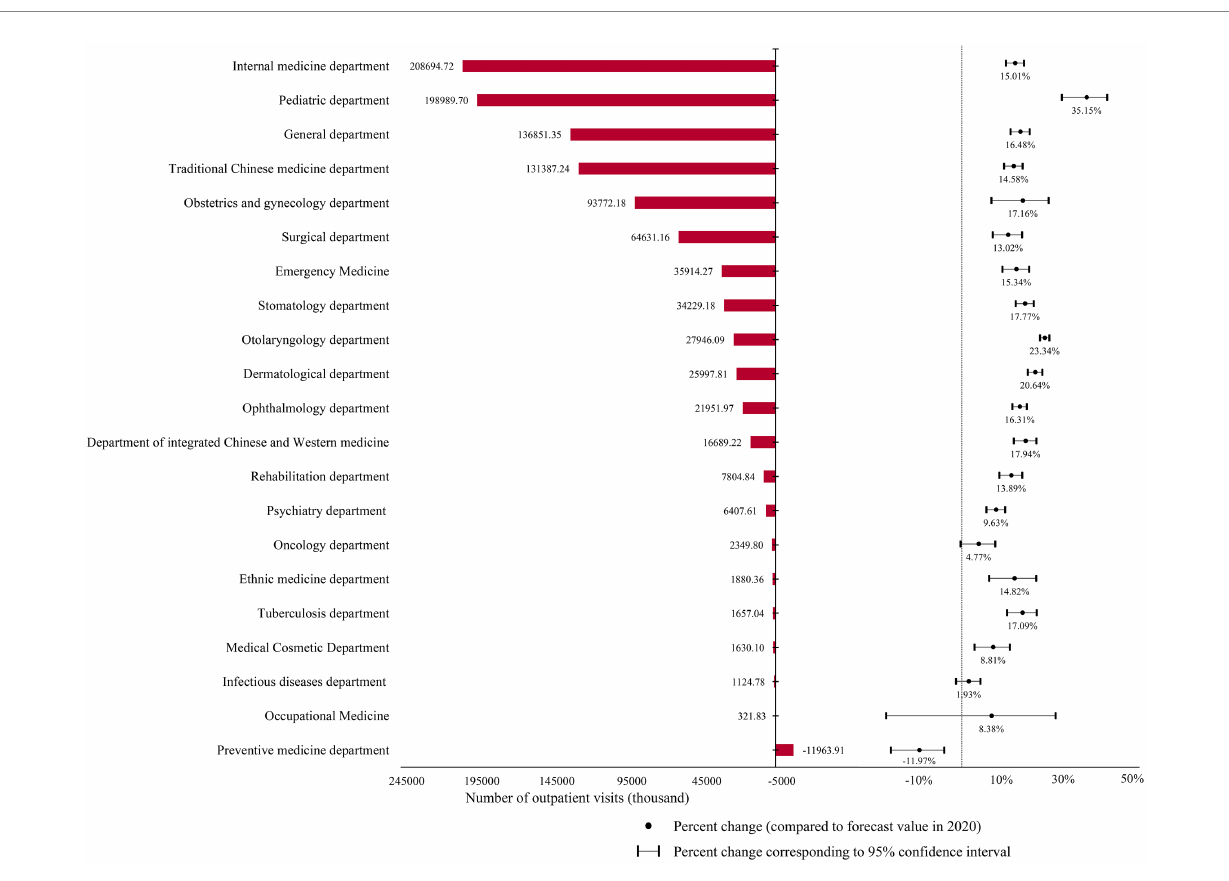
FIGURE 3 The difference between the predicted and actual values of outpatient visits in different hospital departments in 2020 and the percentage change in